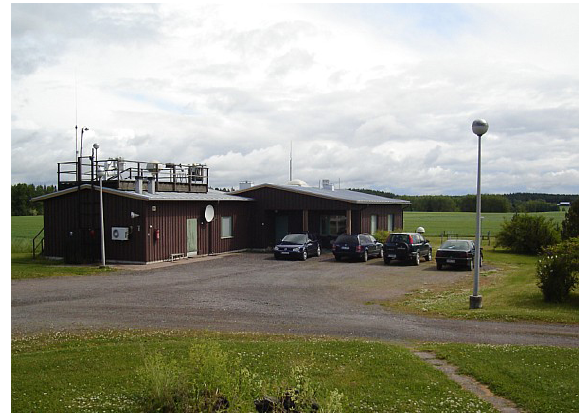
Figure 2. View of Jokioinen observatory. The Brewer is located on the roof in the enclosure on the left.